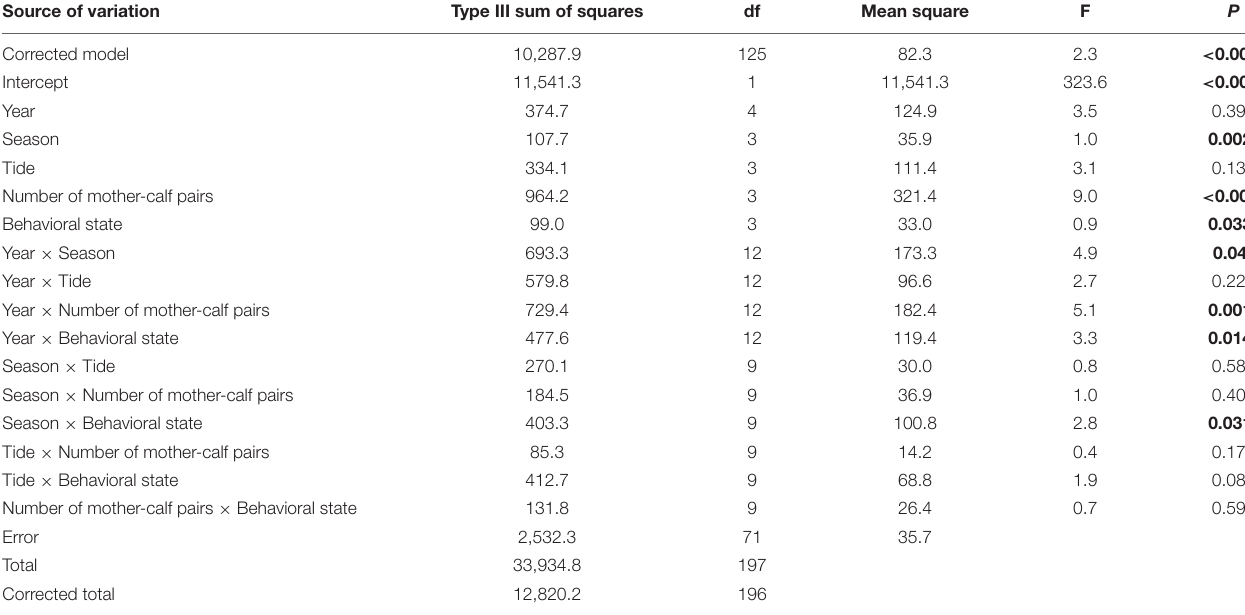
Corrected total